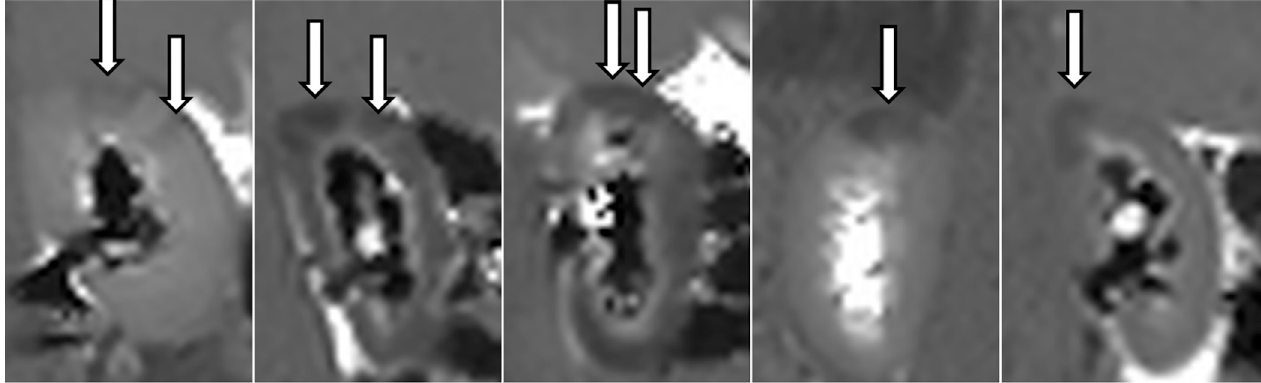
Fig 2. First visual changes. First MR-scan for each of the 5 animals with visual changes appearing as dark areas (arrows). In animal no. 4 the study was performed on the right kidney due to catheter placement failure on the left side. 1: 22 min—25 mmHg 2: 5 min– 20 mmHg 3: 25 min– 22 mmHg 4: 20 min– 22 mmHg 5: 5 min– 16